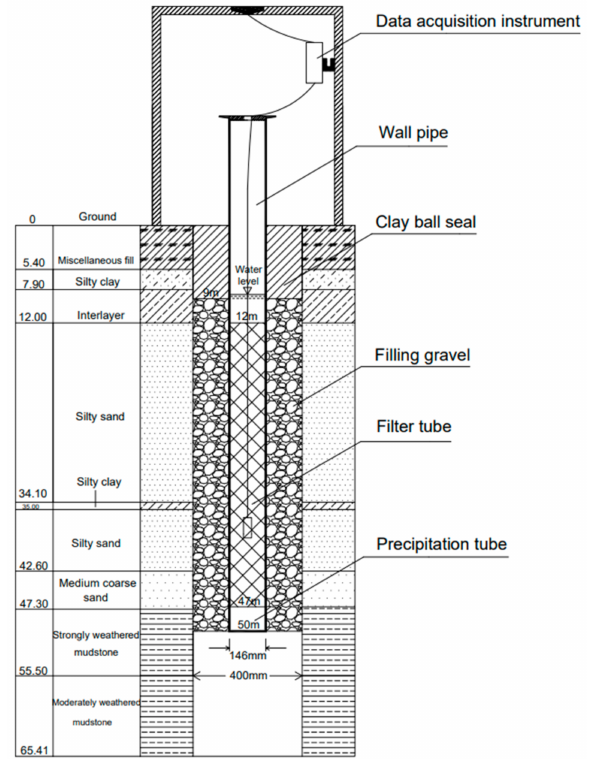
Figure 3. Structural design of a monitoring well.